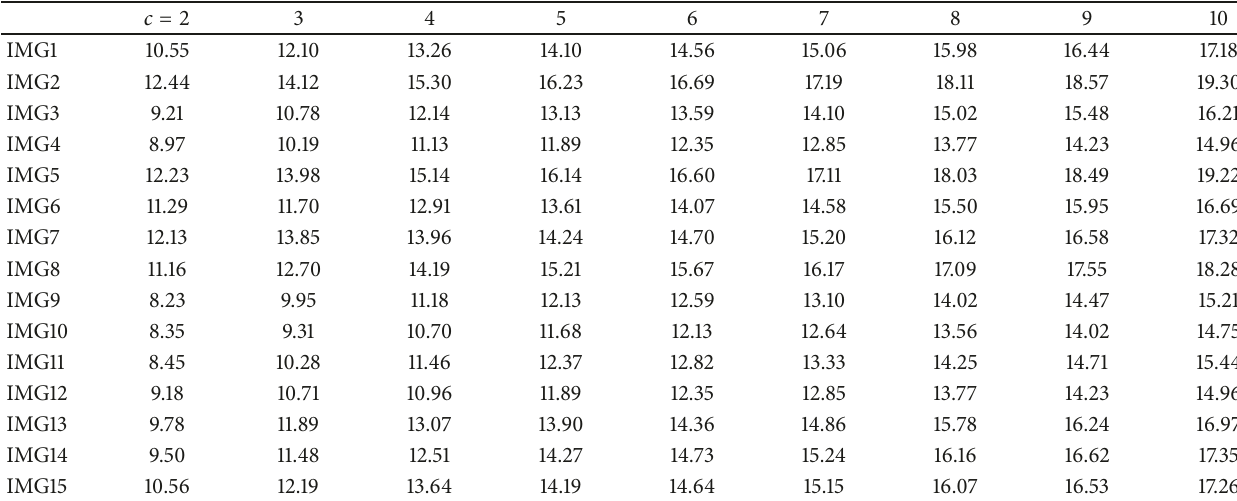
Table 13: PSNR using FCRM with different cluster